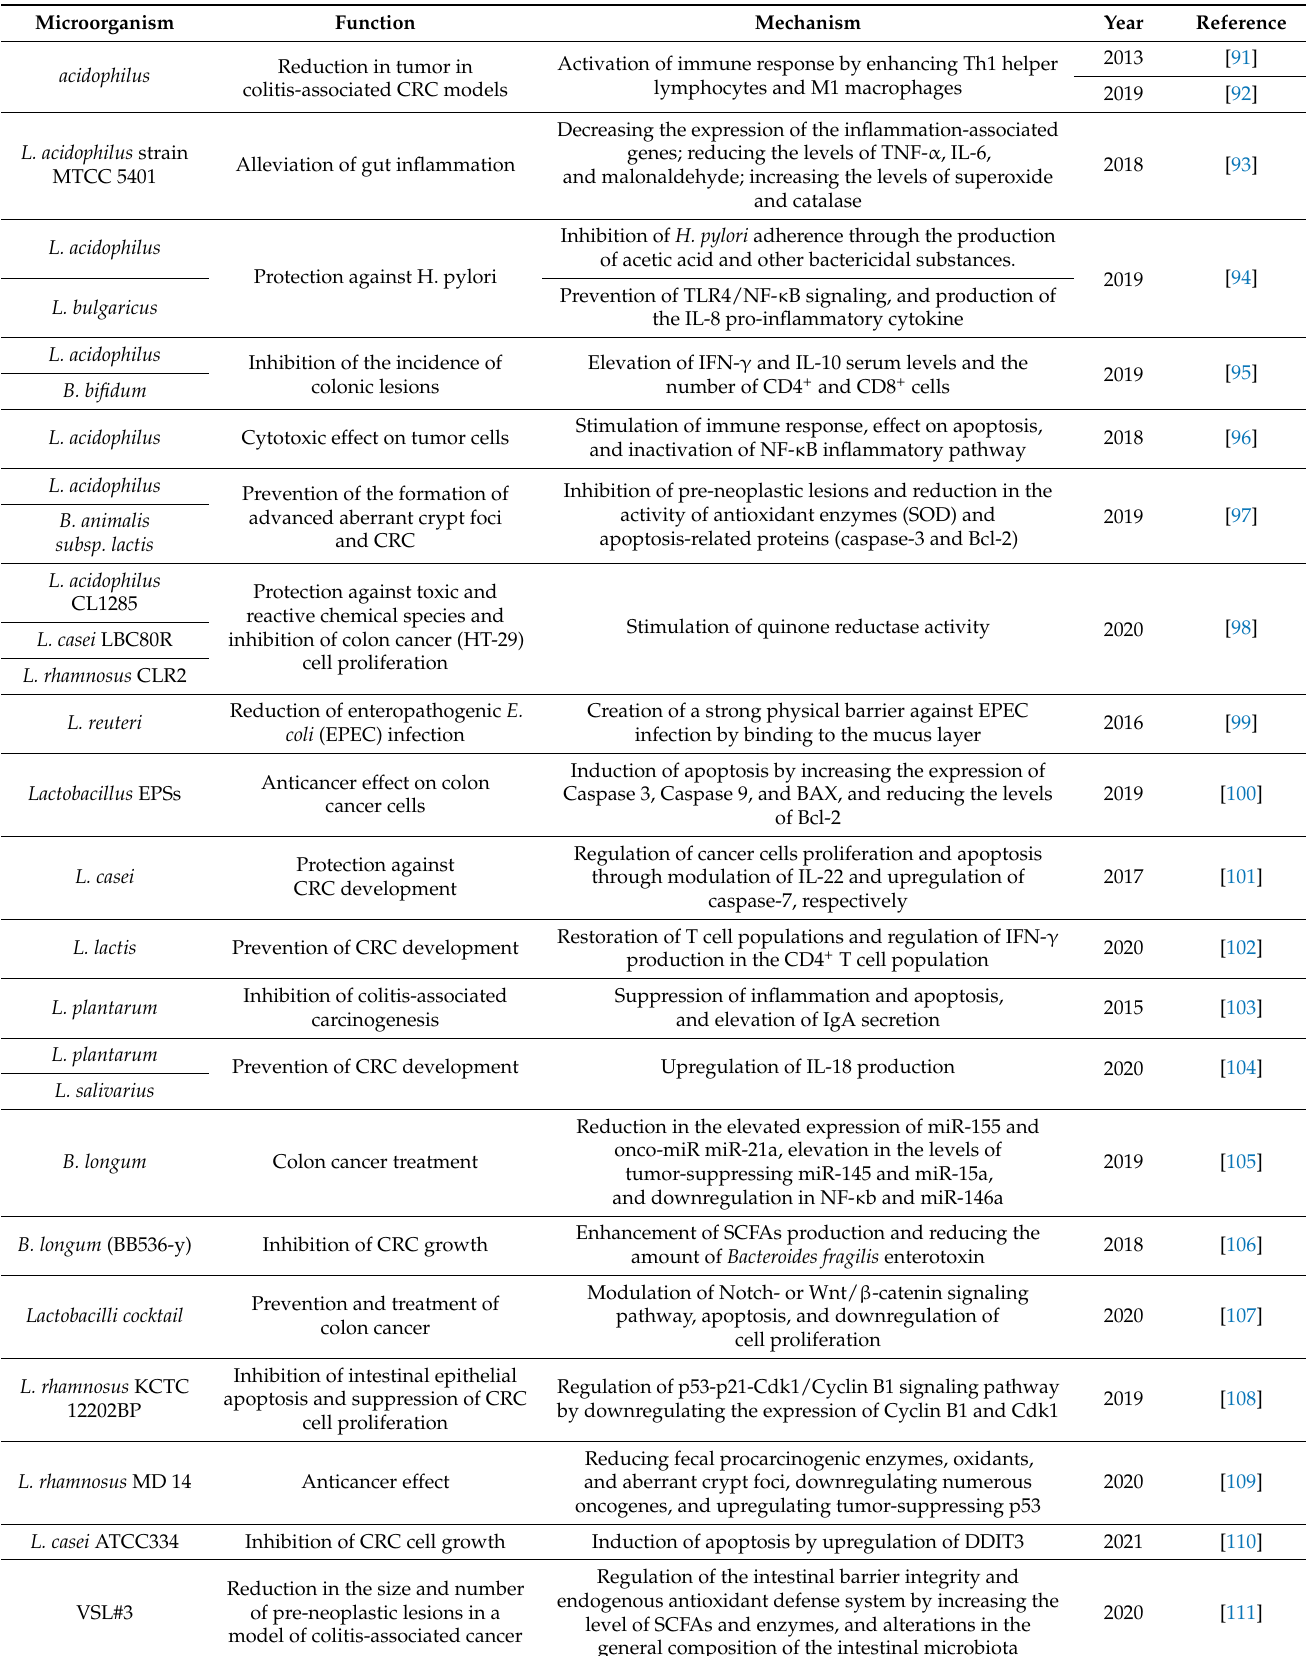
Table 1. List of probiotics used in in vitro and in vivo CRC